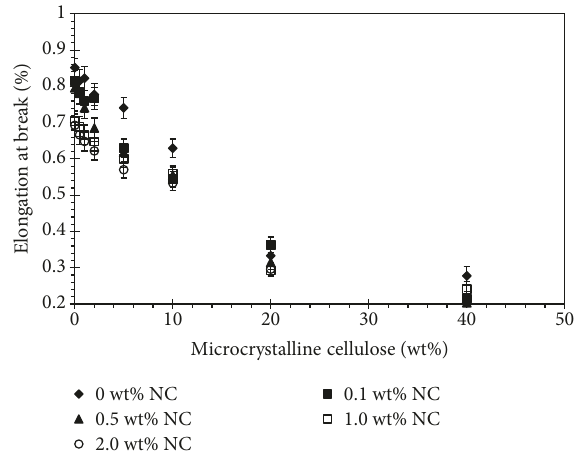
Figure 13: Elongation at break of PP/MCC composites as a function of NC wt%.